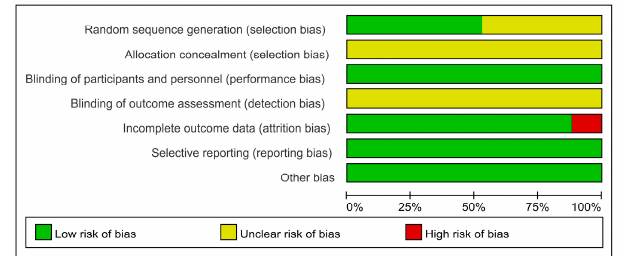
Figure 2. Risk of bias graph of included studies.